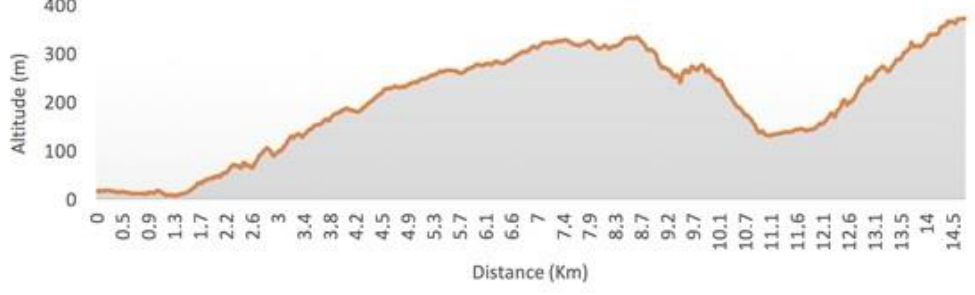
Figure 7. Profile (in altitude) of the analyzed route. Sensors 2018 , 18 , 220